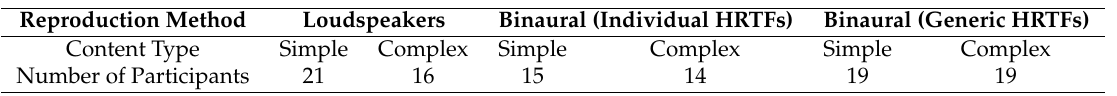
Table 3. Number of participants who completed the tests grouped by the rendering method and audio content type